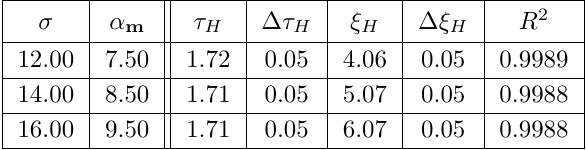
Table 5 . Linear fit parameters log H +